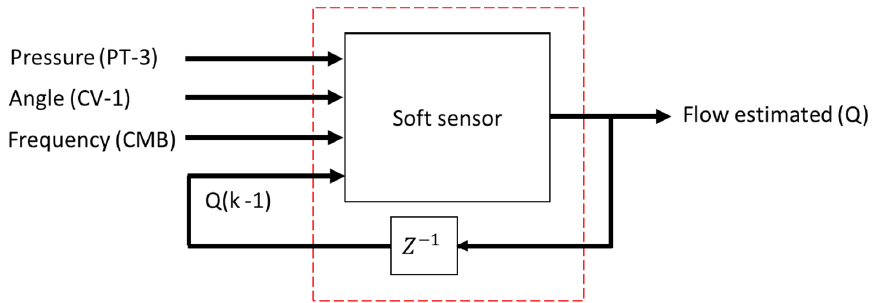
Figure 9. Diagram of ANN ‐ NARX with feedback.